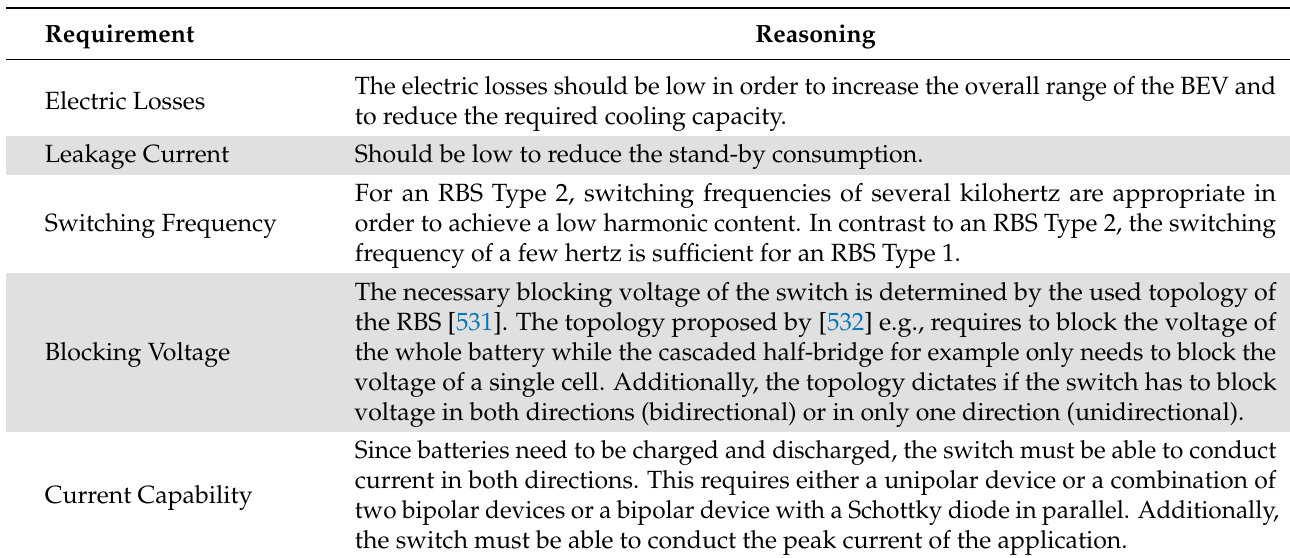
Table 8. Requirements related to the switches of